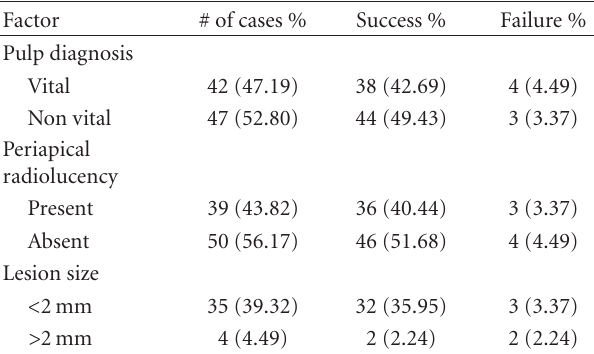
Table 4: Relationship of preoperative factors to treatment results in root canals filled with gutta-percha and ER.